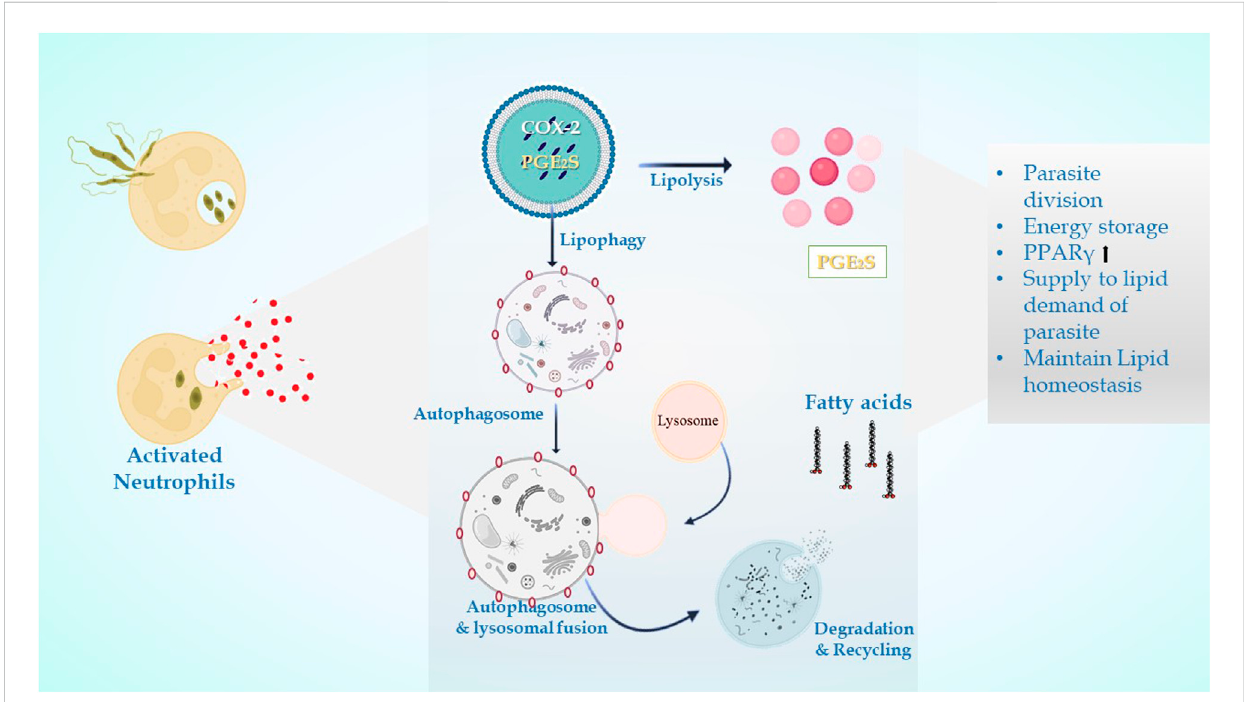
FIGURE 4 In leishmanial infection, lipid droplets are induced in the host during infection in response to provide lipids for parasite survival and for their differentiation. Within the LDs of stimulated cells acquired under infectious circumstances, the key eicosanoid-forming enzymes, cyclooxygenase, 5-lipoxygenase (5-LO), 15-LO, and PGE2 synthase were discovered. The synthesis of prostaglandin E2 aids in parasite survival. The production of signals that cause LD formation, fatty acid intake, lipid storage, and in fl ammatory response has been identi fi ed to involve PPAR γ